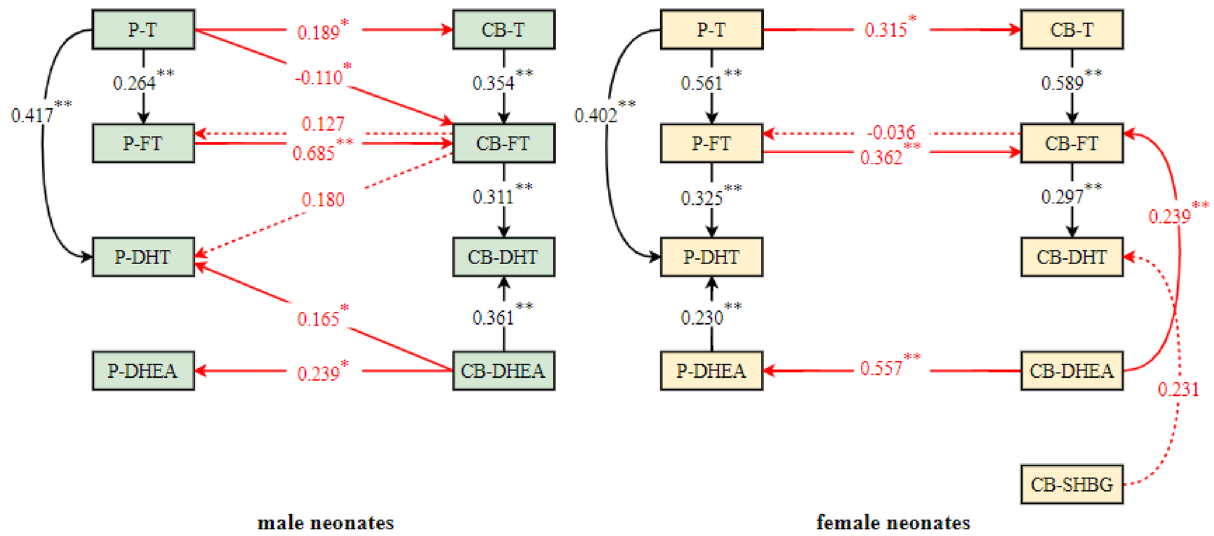
Figure 5. Association path models between prenatal androgens and cord blood androgens. Notes: P-T prenatal testosterone, P-FT prenatal free testosterone, P-DHT prenatal dihydrotestosterone, P-DHEA prenatal dehydroepiandrosterone, CB-T cord blood testosterone, CB-FT cord blood free testosterone, CB-DHT cord blood dihydrotestosterone, CB-DHEA cord blood dehydroepiandrosterone, CB-SHBG cord blood sex hormone binding globulin; Black arrow, already known data; Red arrow, new findings data; * P < 0.05; ** P < 0.01. Paths β SE P 95% CI Direct